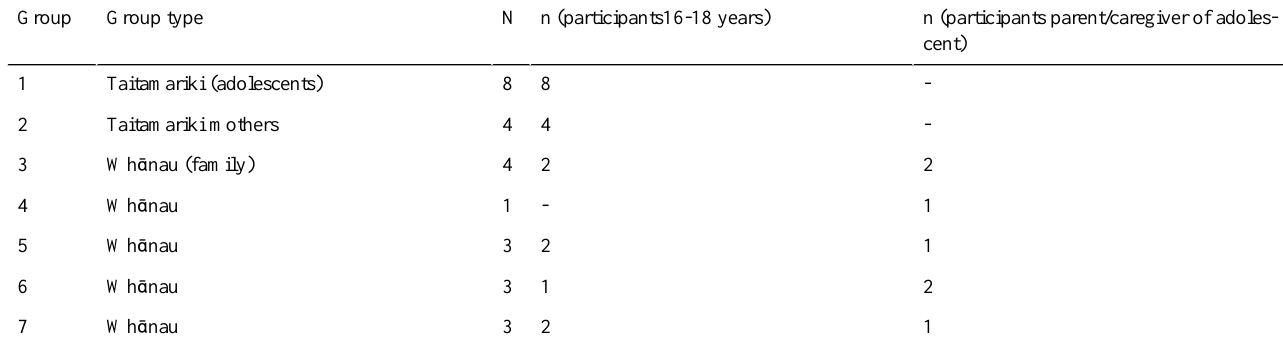
Table 1. Number and type of focus groups and participants.